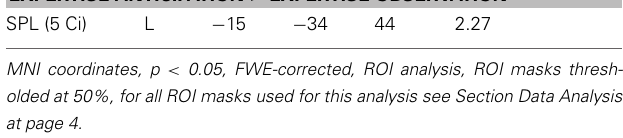
Table 3 | Brain areas showing stronger activation as a function of the number of correct responses in serve anticipation in the expertise sport when contrasting the anticipation of serves in the respective expertise sport with the ball bouncing condition in the corresponding expertise sport in all 31 participants. L/R X Y Z t -value SUIT EXPERTISE ANTICIPATION > EXPERTISE OBSERVATION SPL (5 Ci)